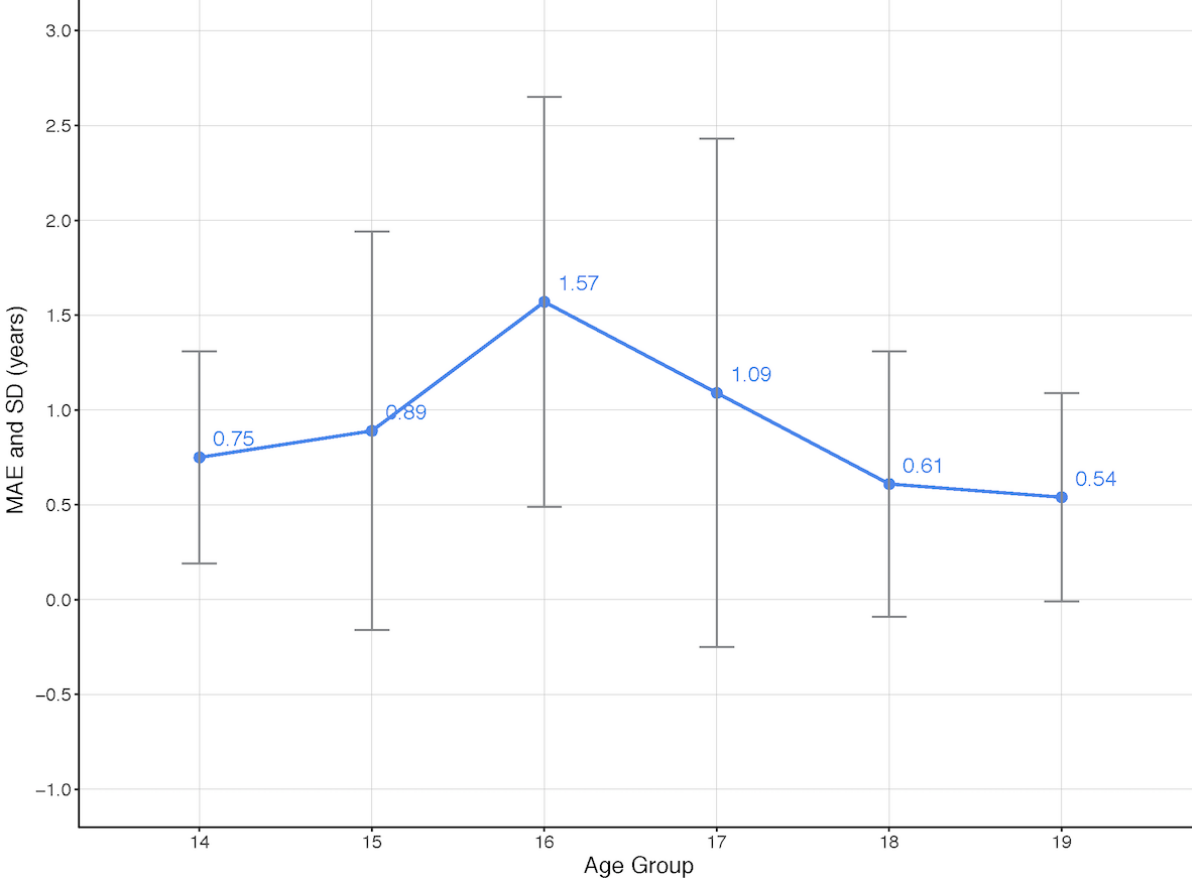
Classification Performance of Minors Versus